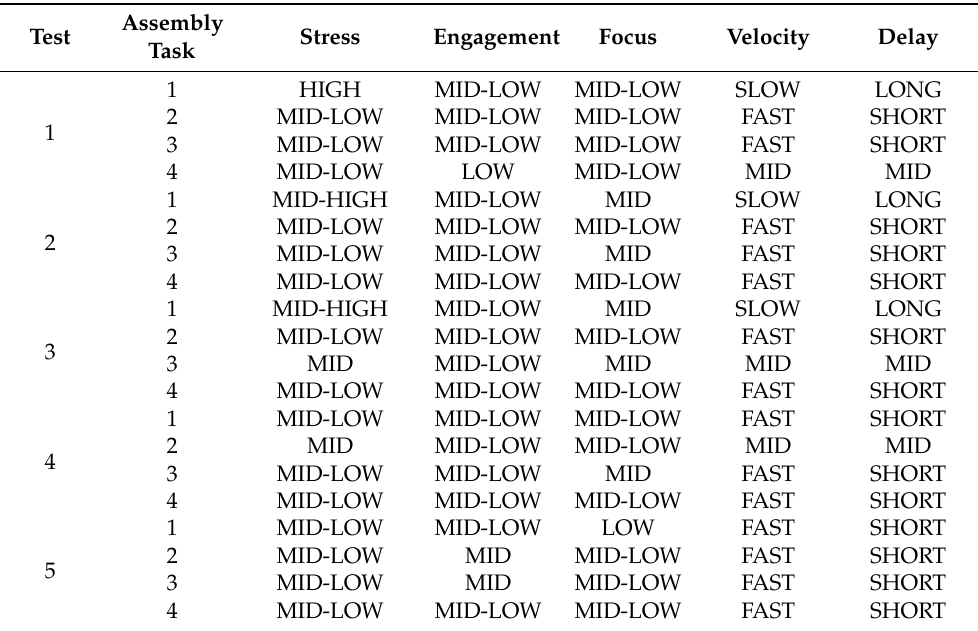
Table 3. Cobot parameters based on the stress, engagement, and the focus levels during the 5 tests.